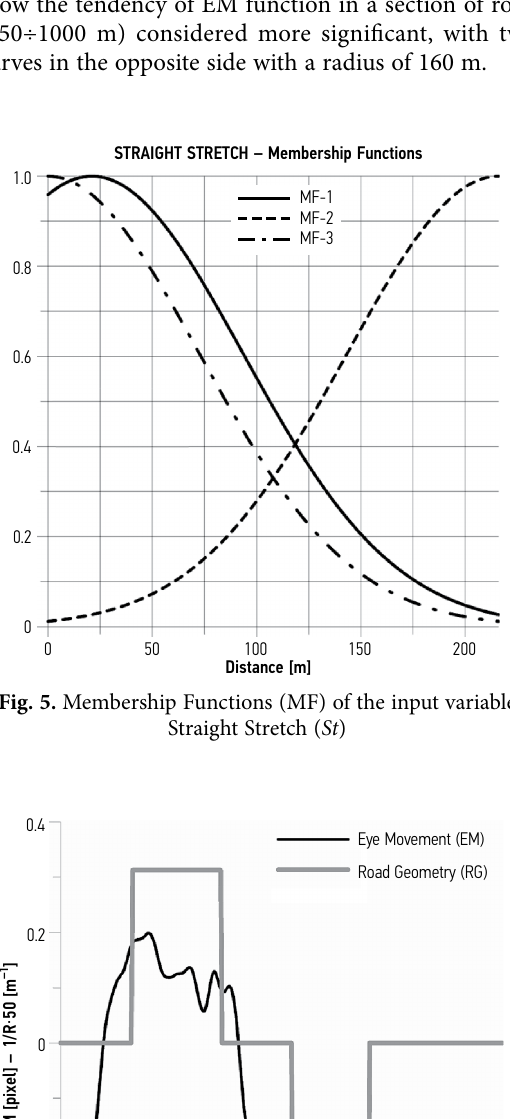
STRAIGHT STRETCH – Membership Functions